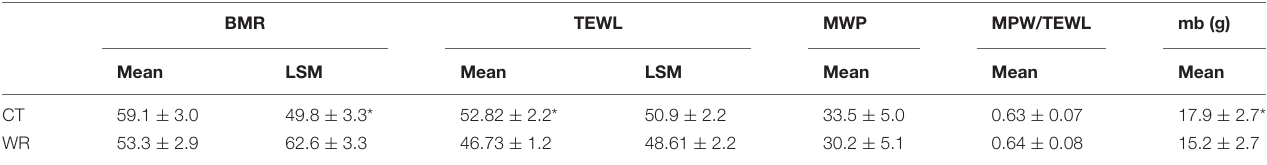
TABLE 3 | Mean ( ± SE) and mass-adjusted (least square means, LSM) basal metabolic rate (BMR, mLO 2 h − 1 ) and total evaporative water loss (TEWL, mg H 2 O h − 1 ), estimated metabolic water production (MWP, mg H 2 O h − 1 ), the ratio MWP/TEWL and body mass (Mb) of Z. capensis acclimated to water restriction (WR) and control (CT) conditions.